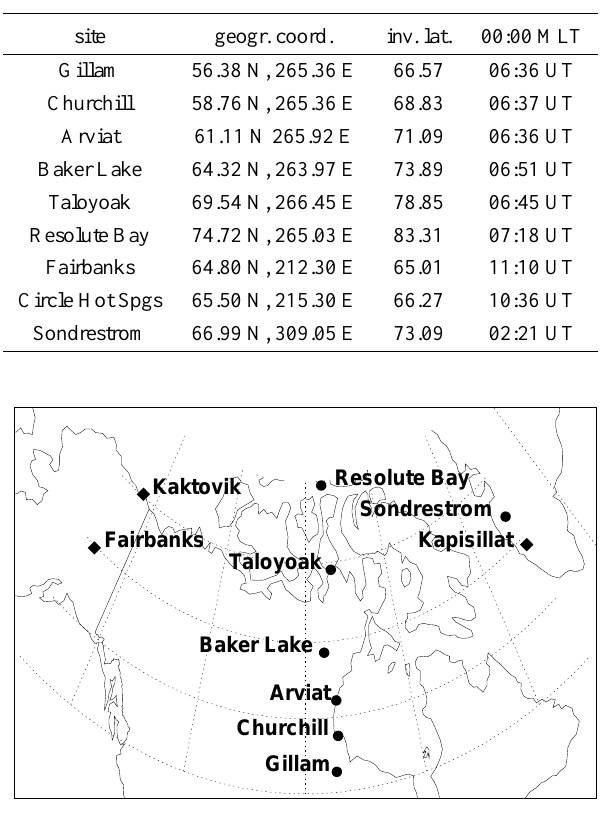
Fig. 1. Map showing locations of Northern Hemisphere LF/MF/HF receivers.